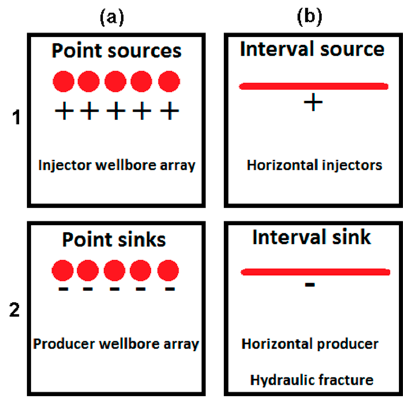
Figure 4. Flow superposition principle diagram. ( a1 ) Point source array, ( a2 ) Point sink array, ( b1 ) Linear interval source, ( b2 ) Linear interval sink. Adapted from Weijermars and Van Harmelen [79].